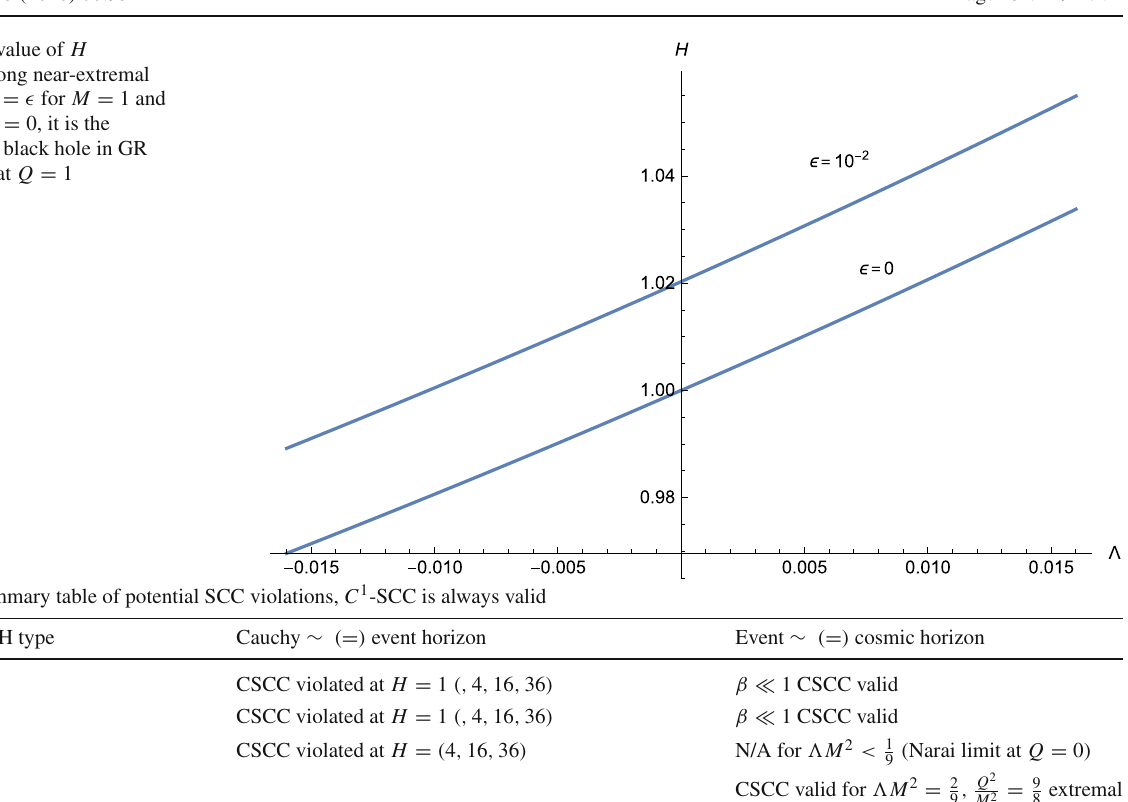
Fig. 8 The value of H calculated along near-extremal line r H − r C = (cid:5) for M = 1 and γ = 0. For (cid:5) = 0, it is the extremal RN black hole in GR with H = 1 at Q = 1